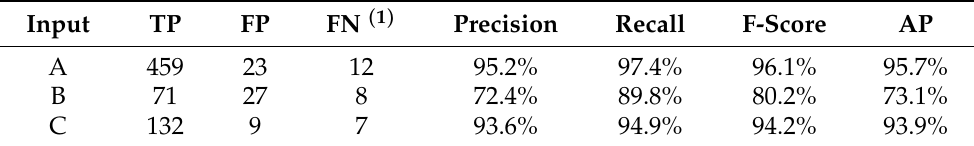
Table 3. Proposed System